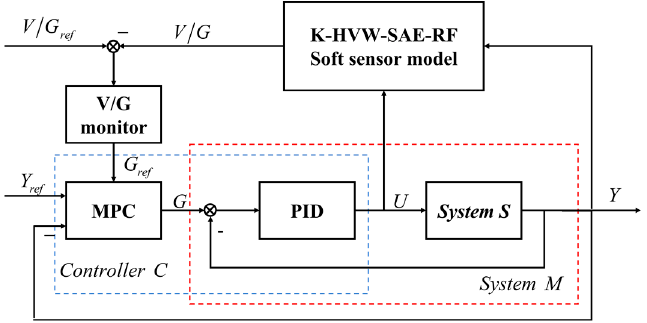
Figure 3. Hierarchical predictive control structure diagram.